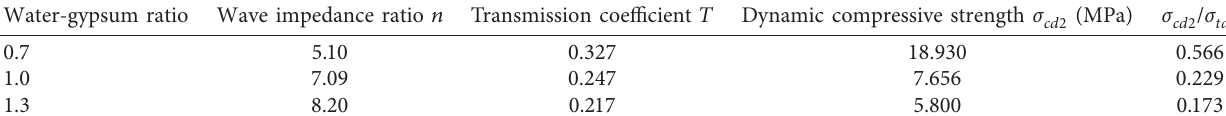
Table 4: Calculated parameters of the original rock and test rods with different water-gypsum ratios. Water-gypsum ratio